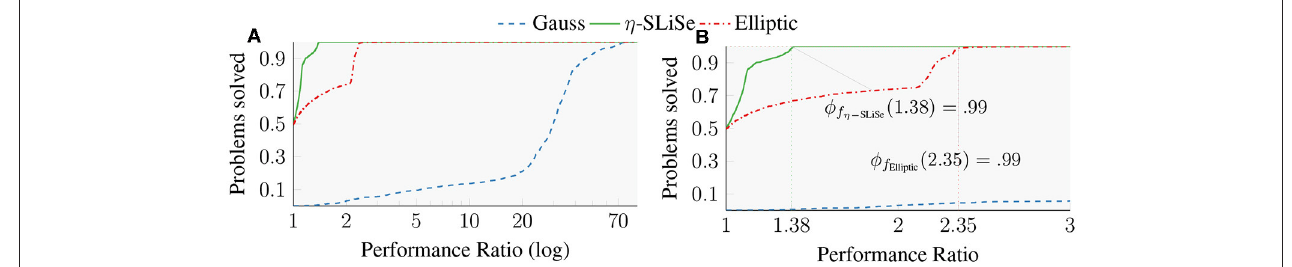
FIGURE 4 | Semi-log performance profile of the convergence ratio for the Gauss, η -SLiSe, and Elliptic filters. η -SLiSe is meant to replace the Elliptic filter. All filters have 16 poles and p = m . (A) Semi-log performance profile of the convergence rate. (B) The same performance profile zoomed into [1, 3] with a linear